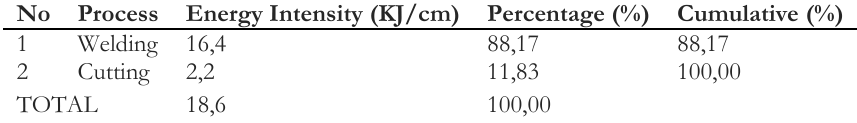
Table 2. Average energy intensity of pipeline construction process in